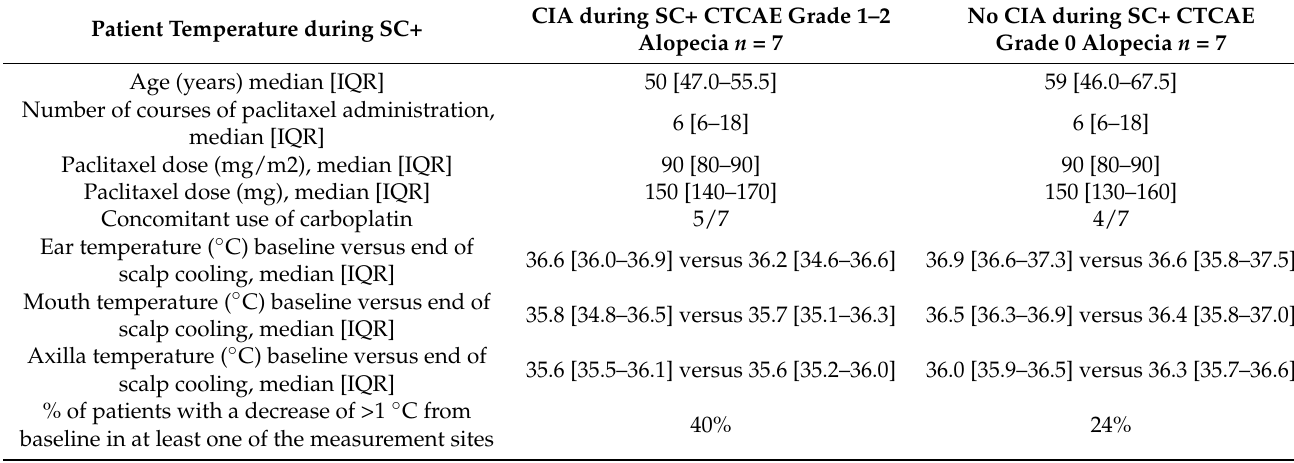
Table 3. Chemotherapy-induced alopecia (CIA) during scalp